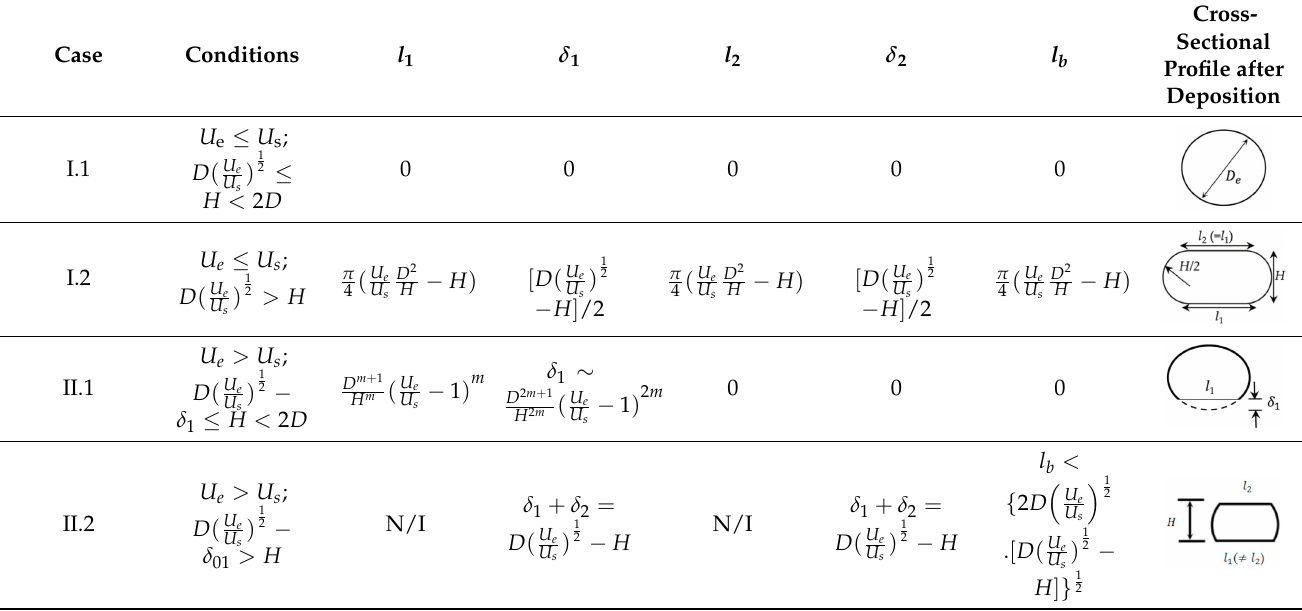
Table 1. Summary of the flat widths, compressed depths, and bonding widths of the deposited strands in the four subcases. Case Conditions l 1 δ 1